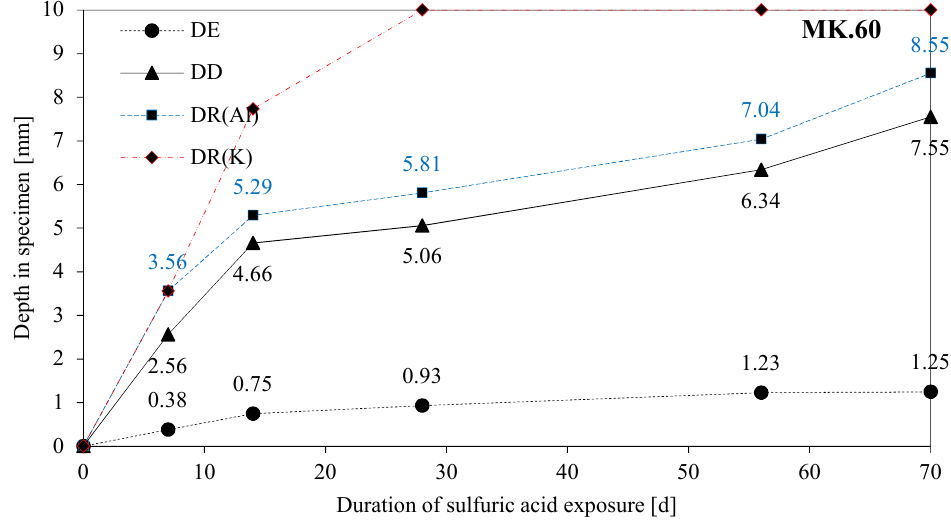
Figure 17. DE (depth of erosion), DD (depth of deterioration), and depth of reaction of aluminum (DR(Al)) and potassium (DR(K)) for MK60, as a function of the duration of exposure in sulfuric acid.